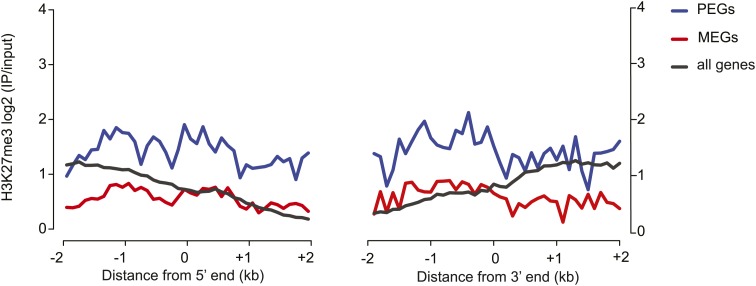
Histone H3 lysine 27 trimethylation (H3K27me3) profiles of PEGs and MEGs in vegetative tissues.H3K27me3 leaf data from Lafos et al. (2011).